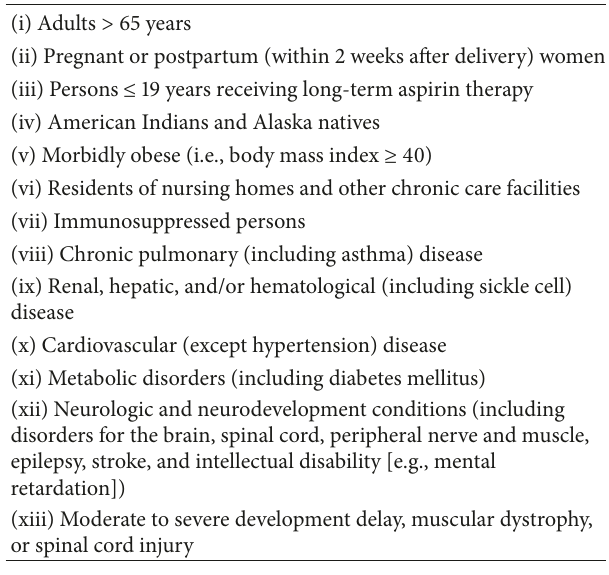
Table 4: Influenza patients at greater risk of bacterial pneumonia